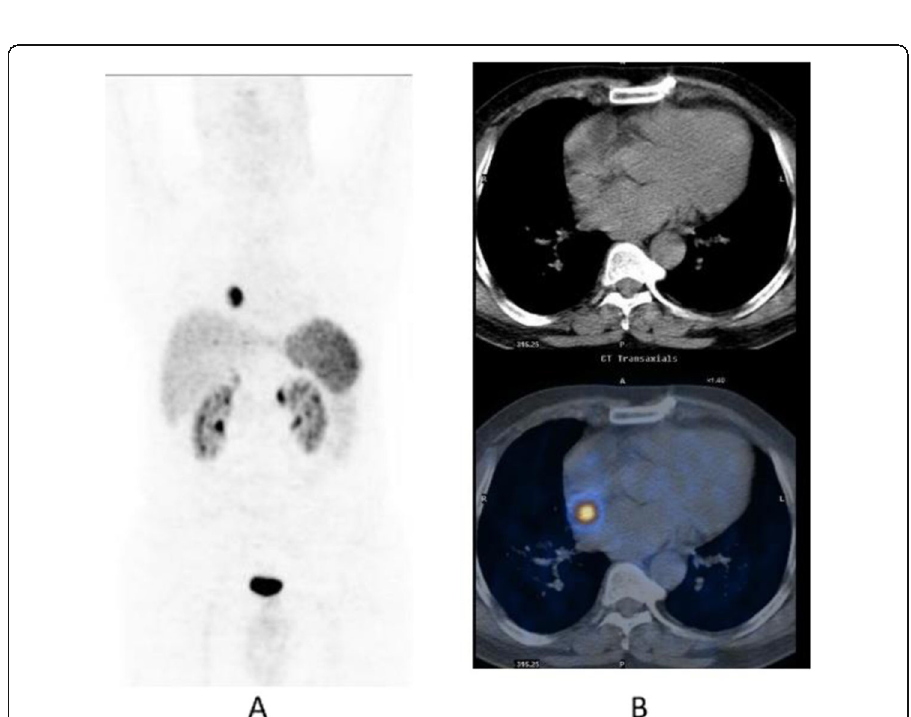
Fig. 61 68 Ga-DOTA peptide, suspected recurrence of paraganglioma. Clinical history : 39 y.o. man with a previous history of paragangliomas. During follow-up CT suspected a relapse in the thorax. PET/CT findings : intense focal uptake in a para-caval round shaped lesion ( a MIP, b CT and fused PET/CT) consistent